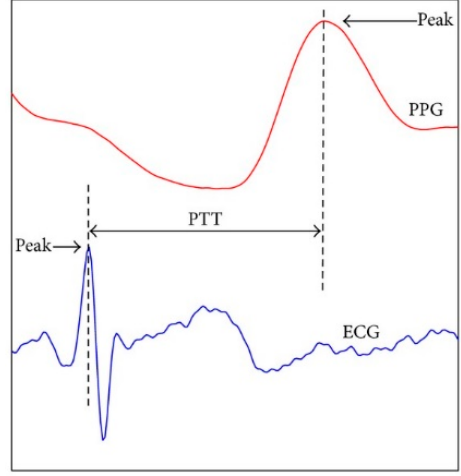
Figure 3. Graphical view of the PTT calculation.